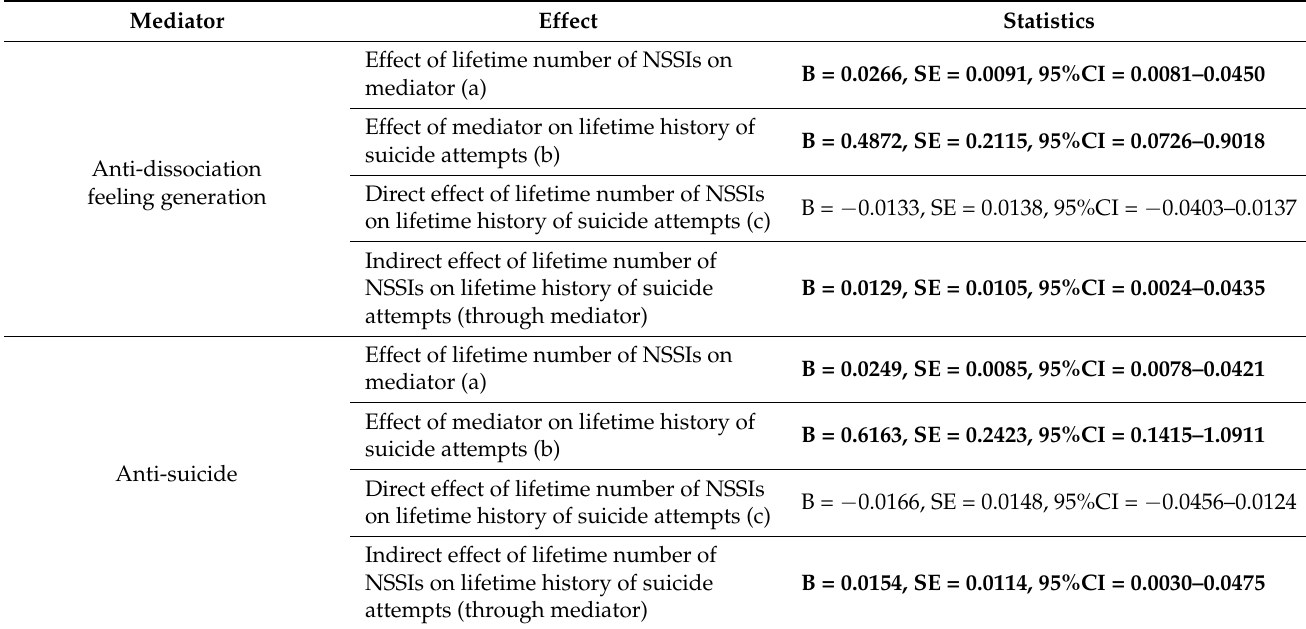
Table 4. Results of mediation analysis after excluding participants with lifetime number of NSSIs higher than